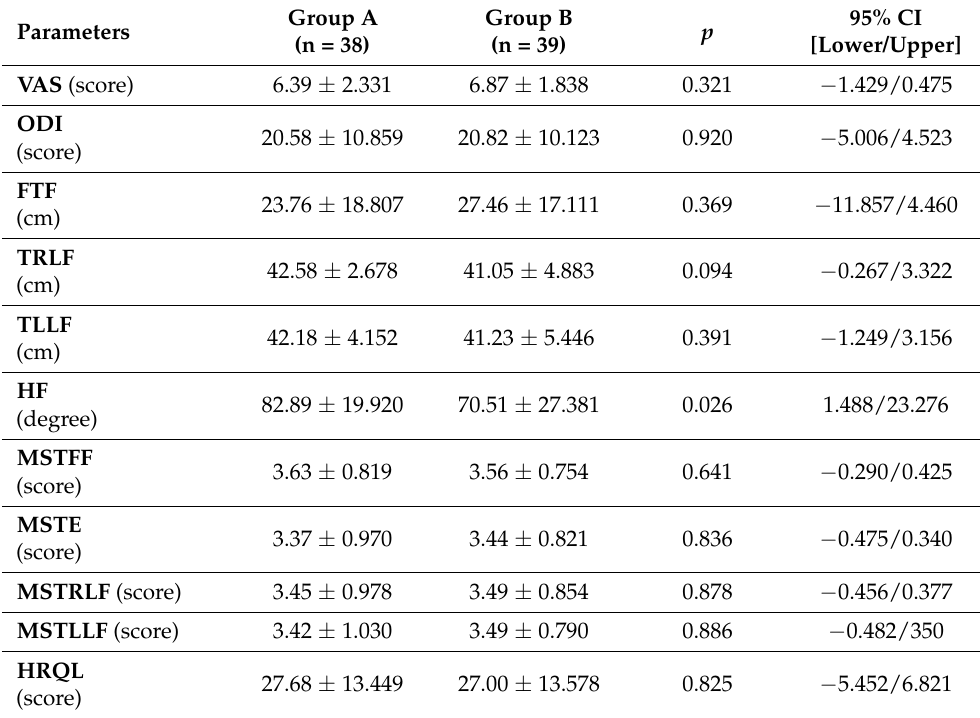
Table 2. Descriptive statistics (mean ± SD) and comparison of the initial parameters (confidence interval 95%) between the two